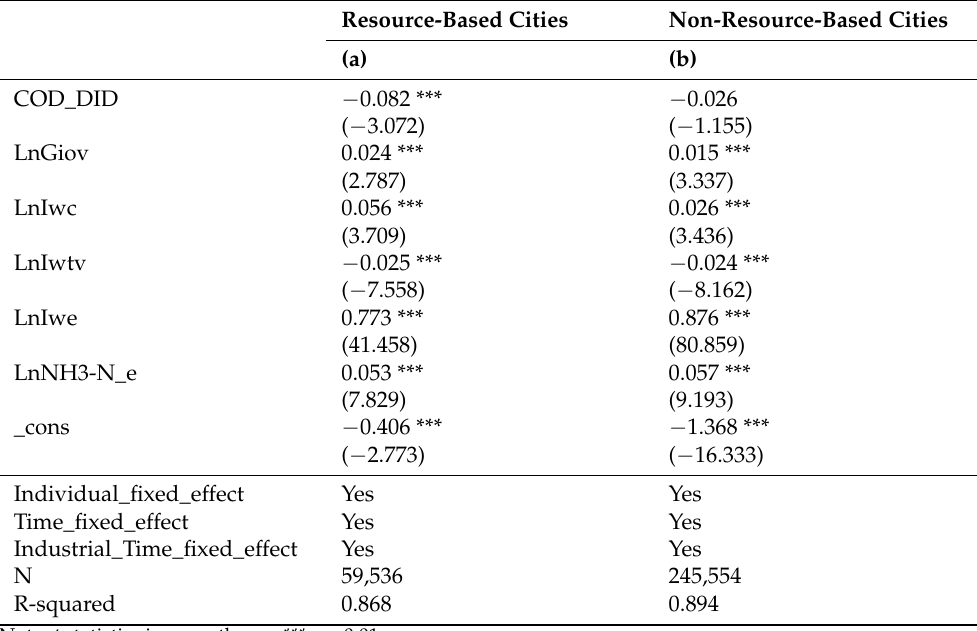
Table 6. Impact of pollution fee reform inside or outside resource-based